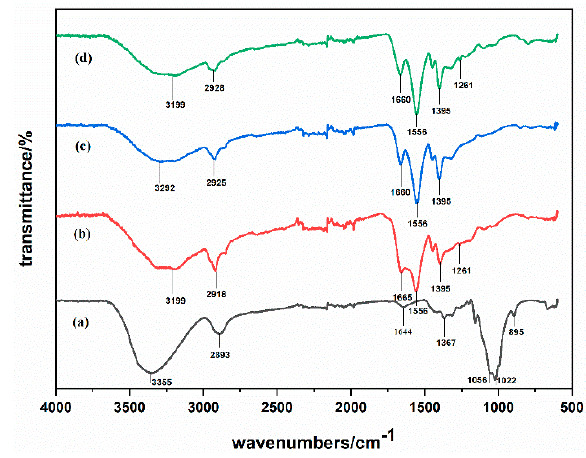
Figure 3. The FT-IR of different hygroscopic exothermic fiber samples: ( a ) collagen protein viscose ( b ) modified PAA ( c ) modified PEA ( d ) modified PAN.